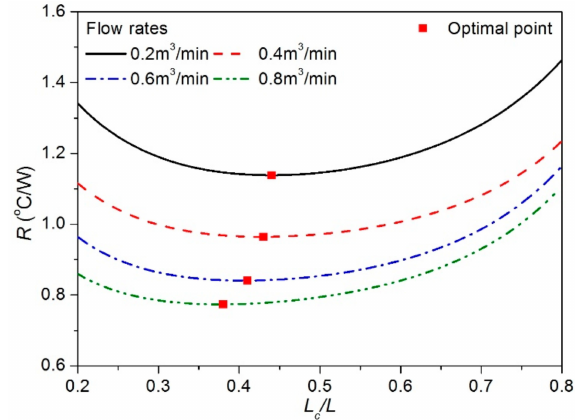
Figure 7. Thermal resistances for various heating positions and flow rates ( w c = 7 mm, L h / L =